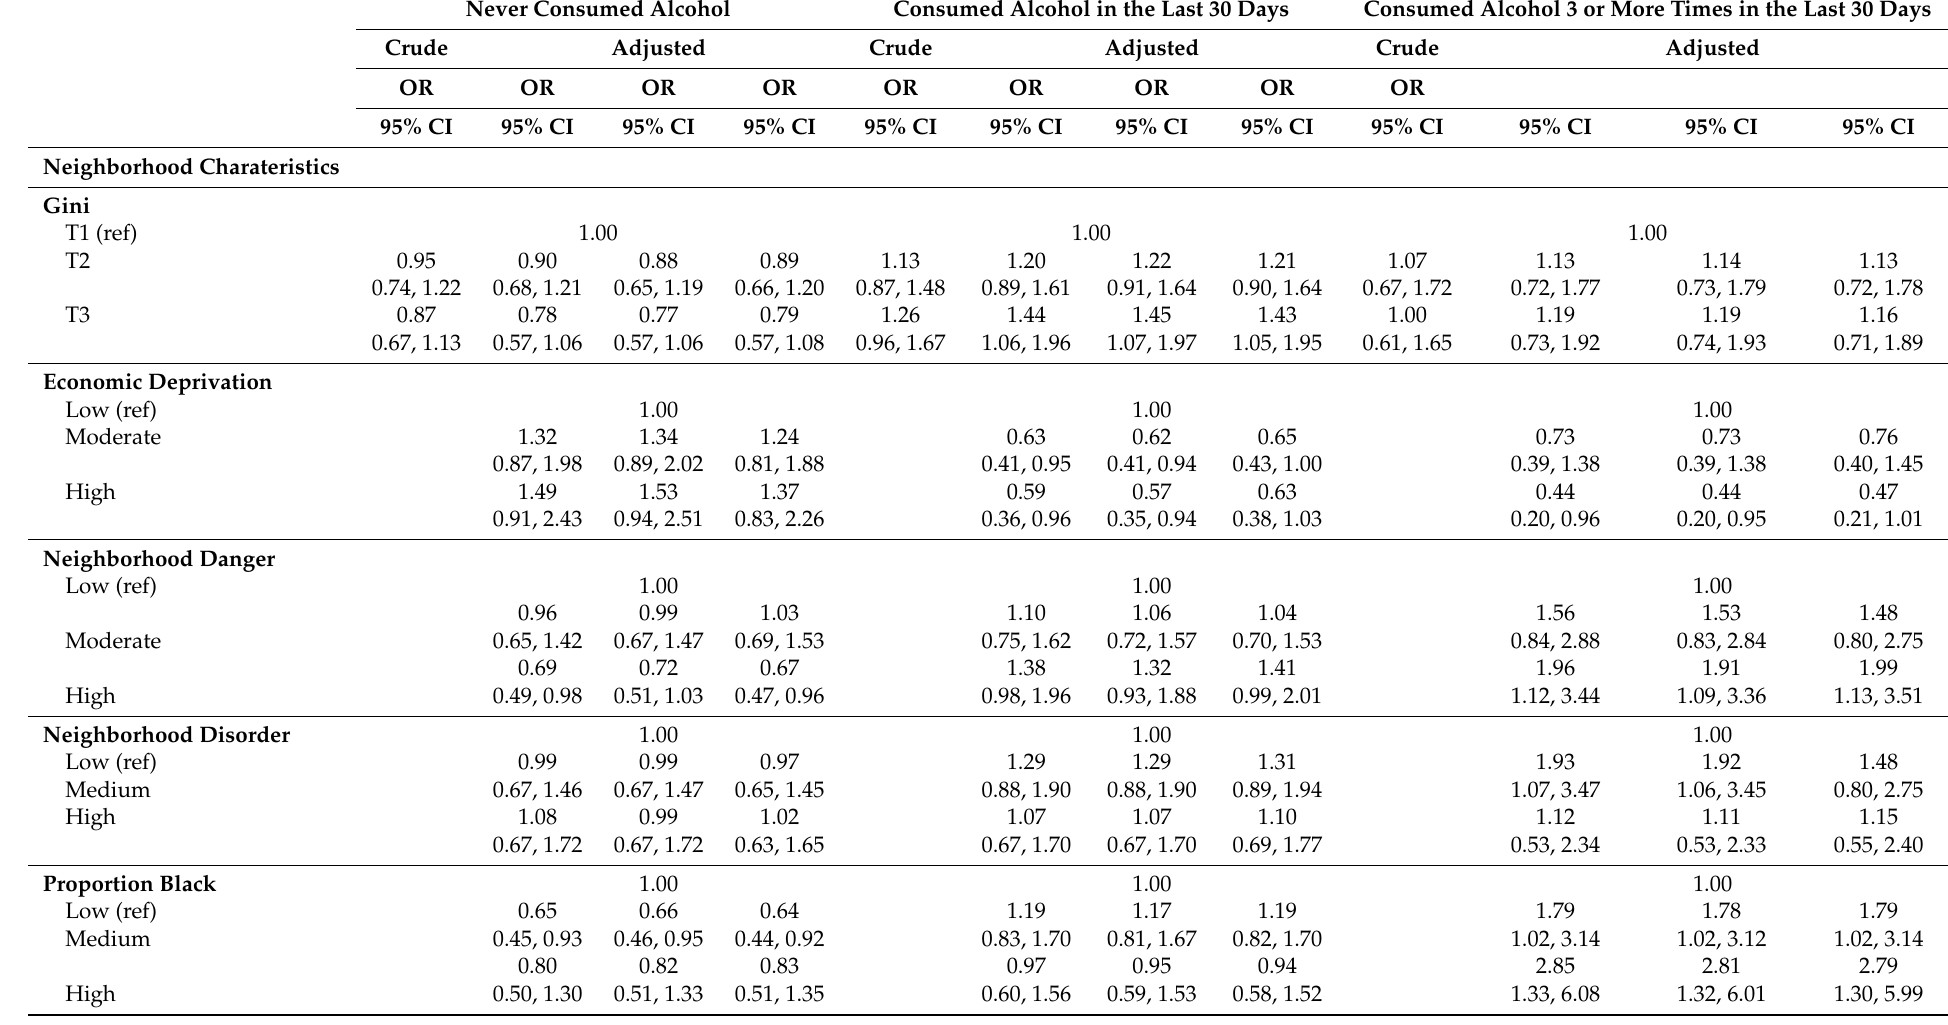
Table 2. The relationship between income inequality and alcohol consumption among students participating in the Boston Youth Study, 2008. Never Consumed Alcohol Consumed Alcohol in the Last 30 Days Consumed Alcohol 3 or More Times in the Last 30 Days Crude Adjusted Crude Adjusted Crude Adjusted OR OR OR OR OR OR OR OR OR 95% CI 95%